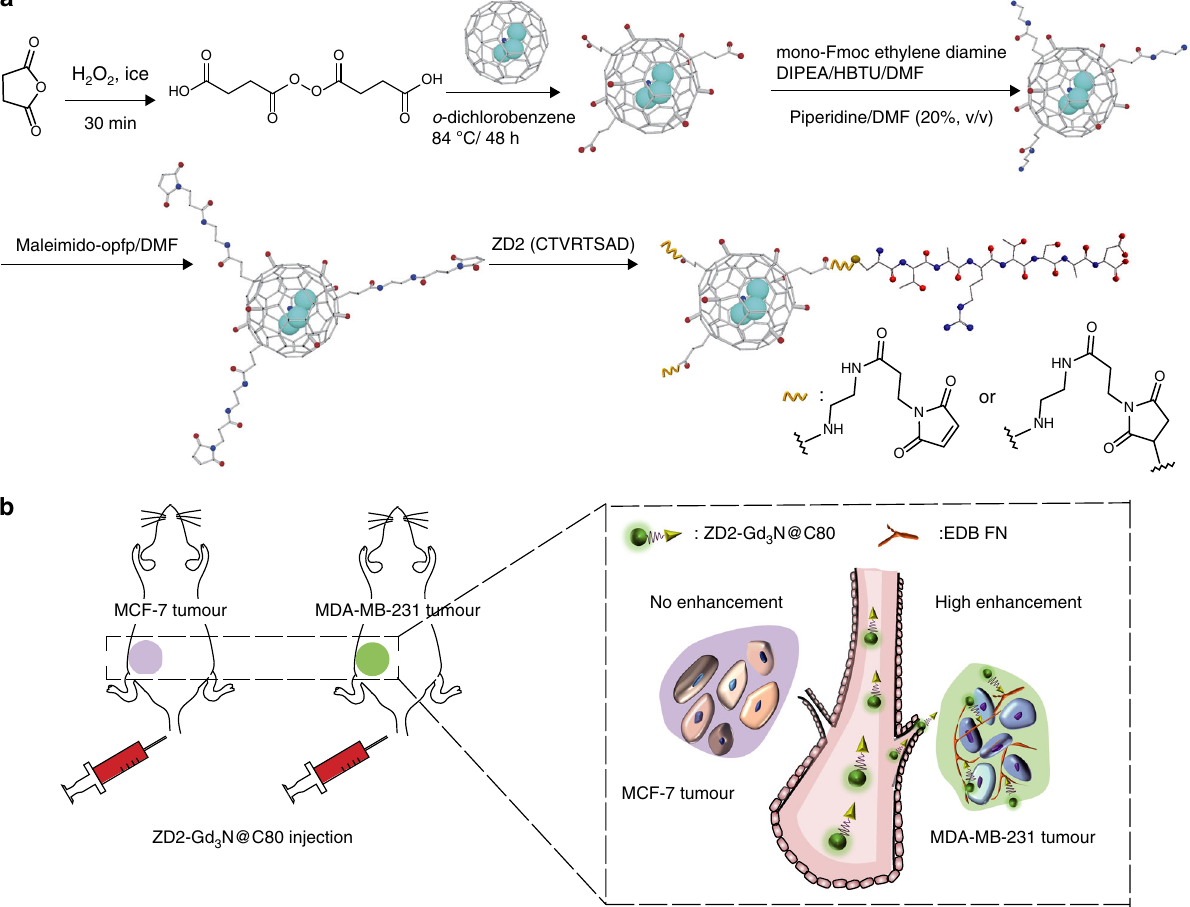
Fig. 1 An EDB-FN-targeting gadofullerene for molecular MRI of breast cancer. a Schematic of synthesis of ZD2-Gd 3 N@C80. Cyan , Gd; blue , nitrogen; red , oxygen; grey , hydrogen. b Illustration of tumour targeting with ZD2-Gd 3 N@C80 for detection and characterisation of breast cancer in mouse models. MCF-7 and MDA-MB-231 cells were used to obtain low-risk and high-risk breast cancer xenografts, respectively. Intravenous injection of the EDB-FN-targeting agent, ZD2-Gd 3 N@C80, results in different binding levels, corresponding to the EDB-FN expression and tumour aggressiveness,